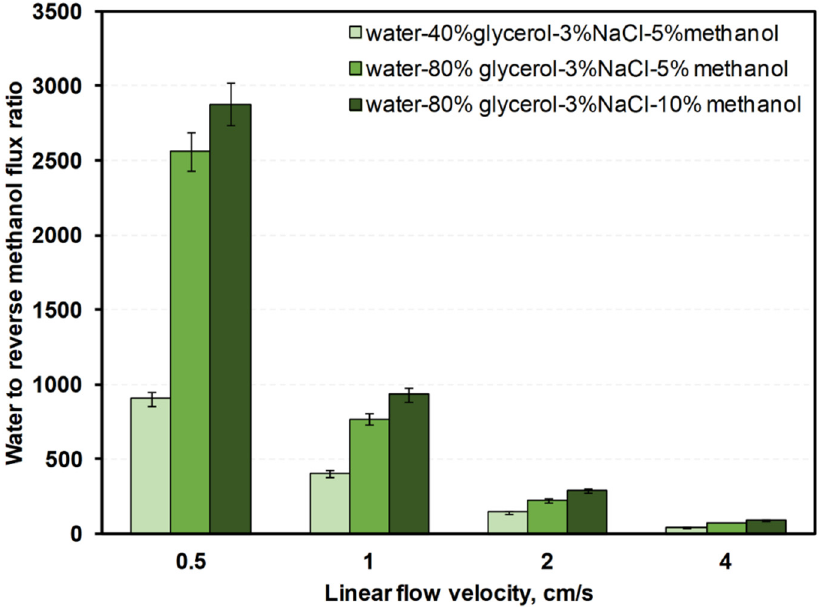
Figure 10. Water-to-reverse methanol mass flux ratios for various linear flow velocities in counter-